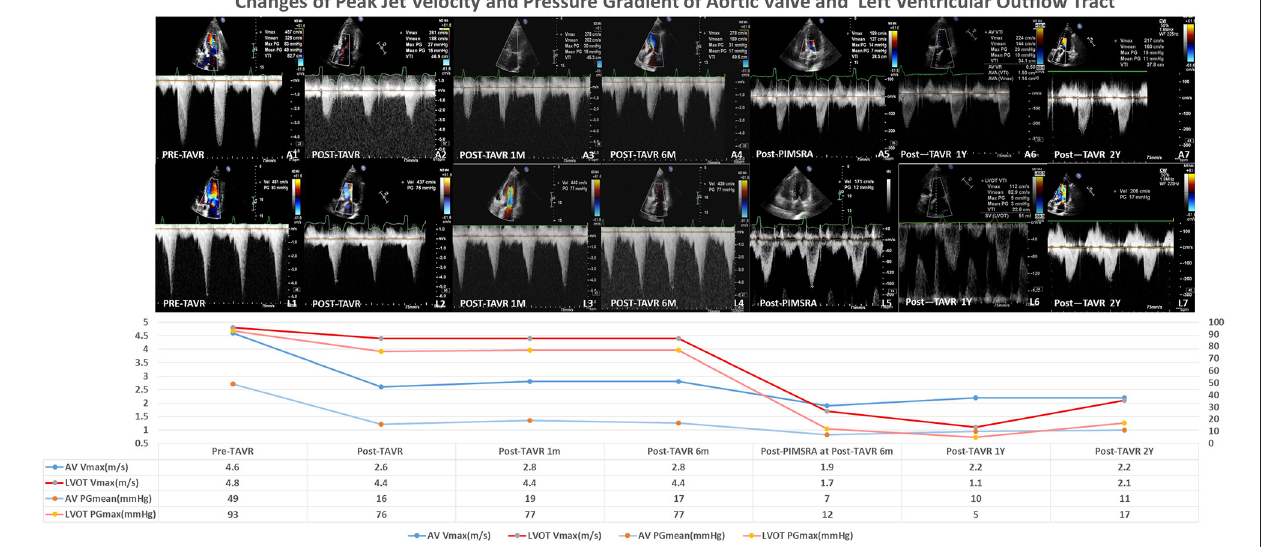
non-transcoronary approach, which could reduce LVOTO and avoid sternotomy, rely on alcohol injection, and damage the conduction system distributed underneath the